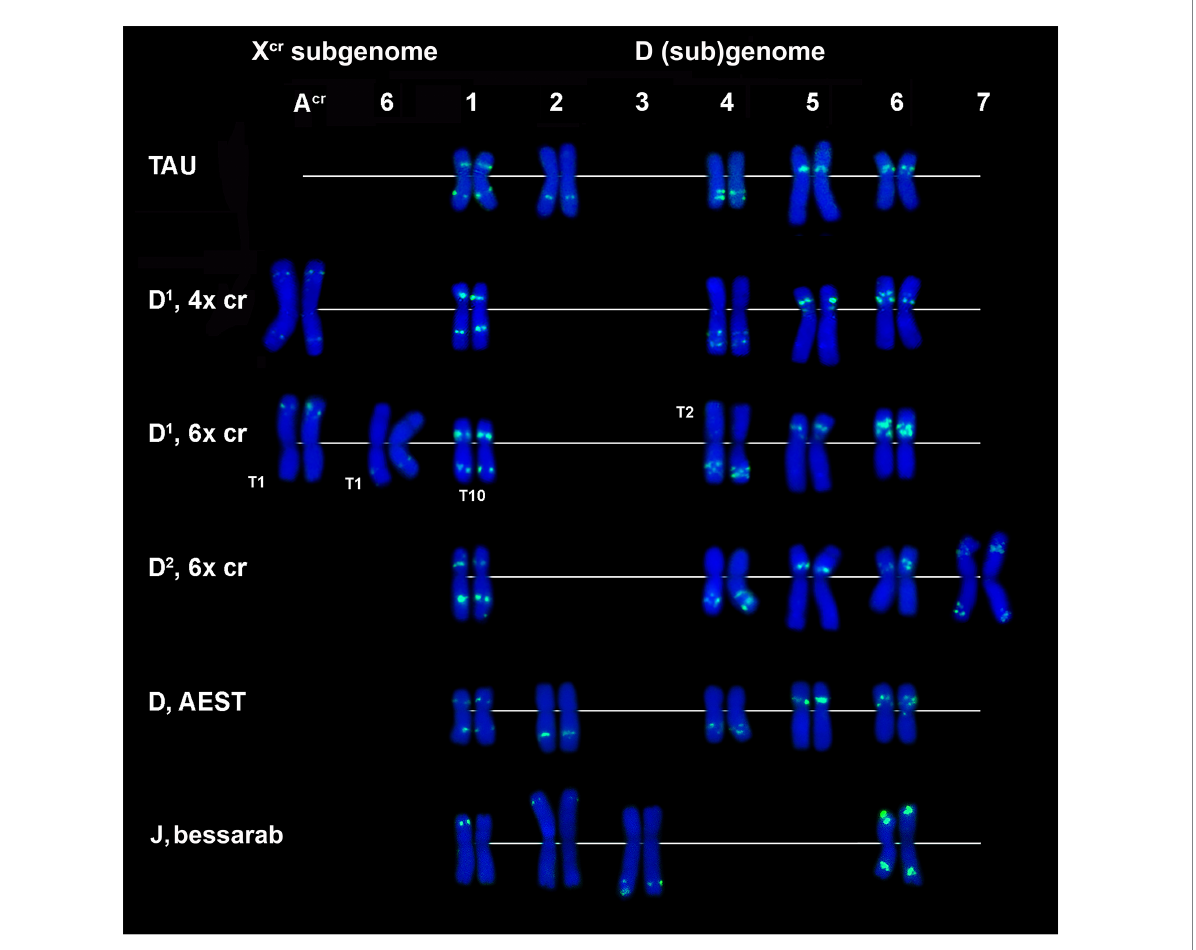
FIGURE 5 Comparison of CL170 patterns on chromosomes of different cereal species: TAU – Ae . tauschii ssp. strangulata; D 1 , 4x cr – D 1 subgenome of tetraploid Ae . crassa ; D 1 , 6x cr, D 2 , 6x cr – D 1 and D 2 subgenomes of hexaploid Ae . crassa; AEST – D subgenome of T . aestivum , J, bessarab – J b genome of Th . bessarabicum . 1–7 – homoeologous groups. T1, T2, T10 – translocated chromosome of Ae . crassa . T10 causes small length reduction of chromosome region distal to CL170 site in the long arm of 1D 1